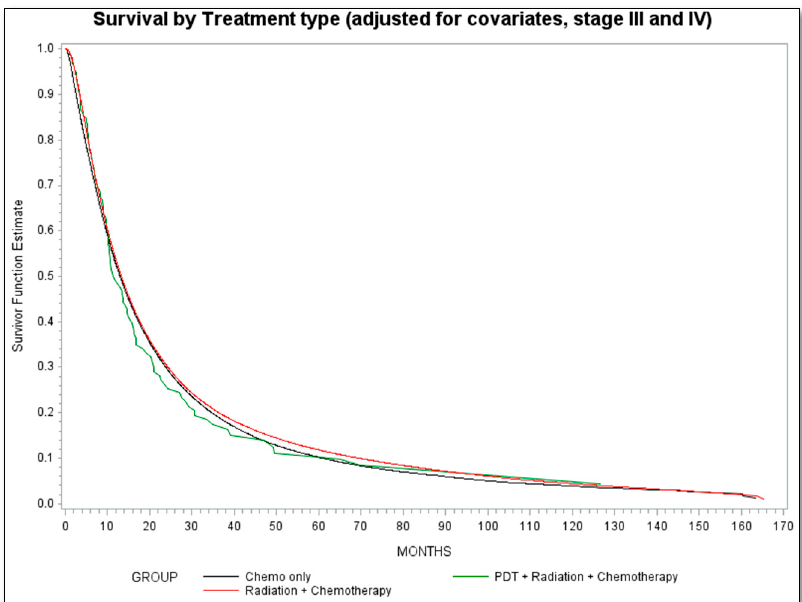
Figure 2. Survival by treatment type-adjusted for covariates, stage III and IV NSCLC. Chemotherapy is reference category.